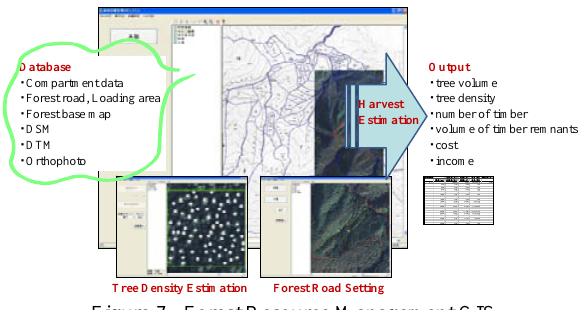
Figure 7. Forest Resource Management